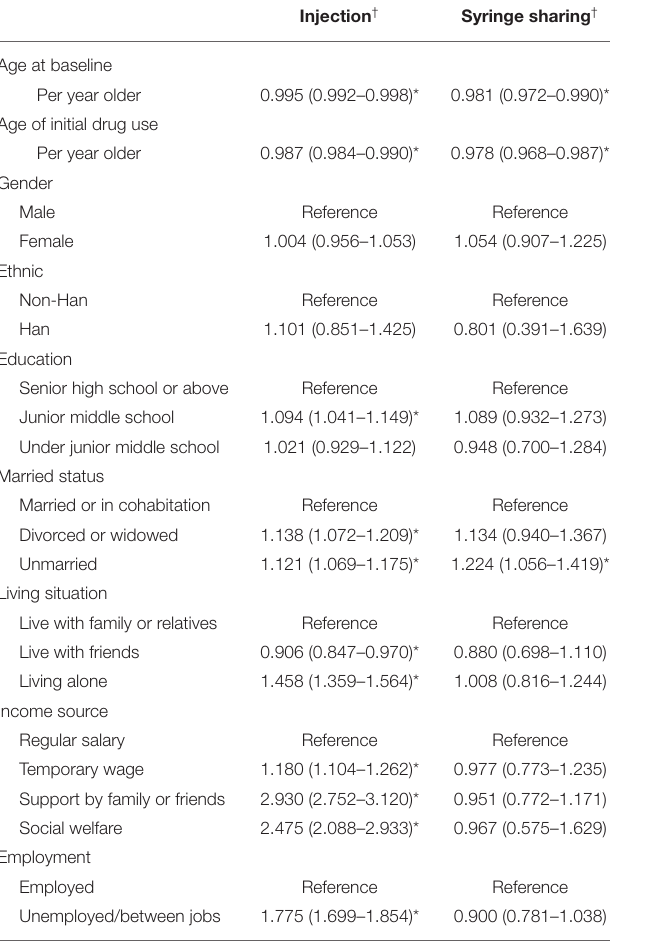
TABLE 2 | Univariable GEE analyses of factors associated with injection and syringe sharing among PWUD on MMT in Wuhan, China, 2006–2015.